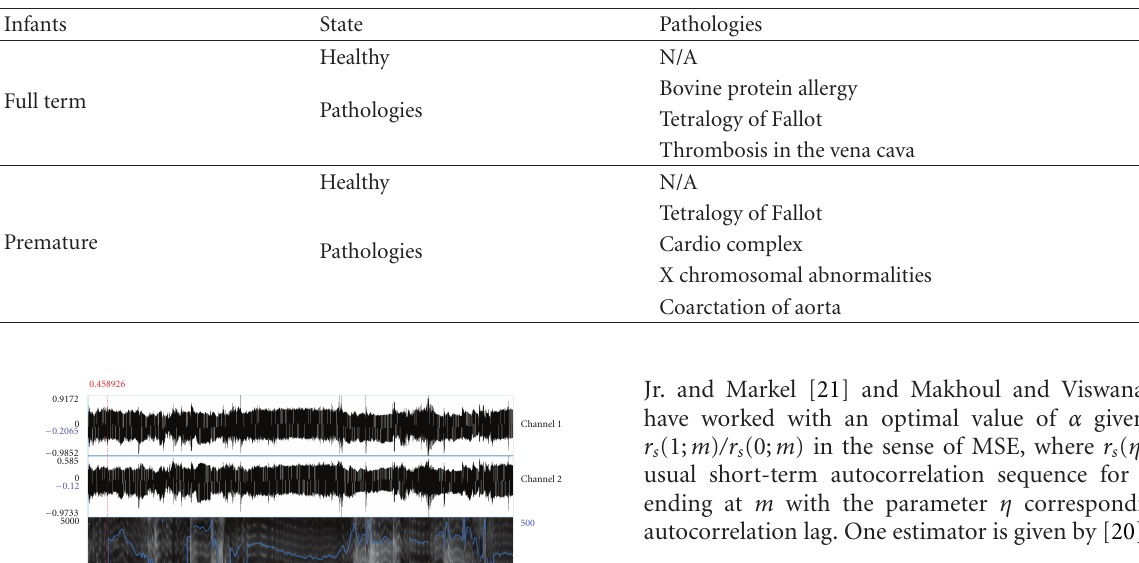
Table 1: Cry database.